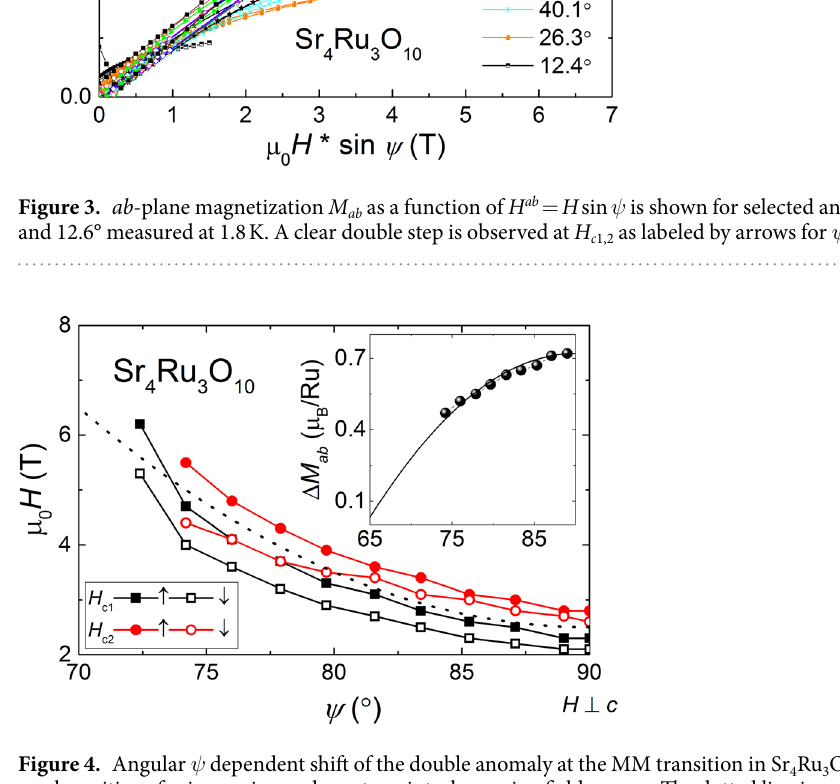
Figure 4. Angular ψ dependent shift of the double anomaly at the MM transition in Sr 4 Ru 3 O 10 . Solid points mark positions for increasing and empty points decreasing field sweeps. The dotted line is a quadratic fit to the data. The inset shows the reduction of the magnetization step Δ M ab at the MM transition as a function of ψ including a quadratic extrapolation marked as solid